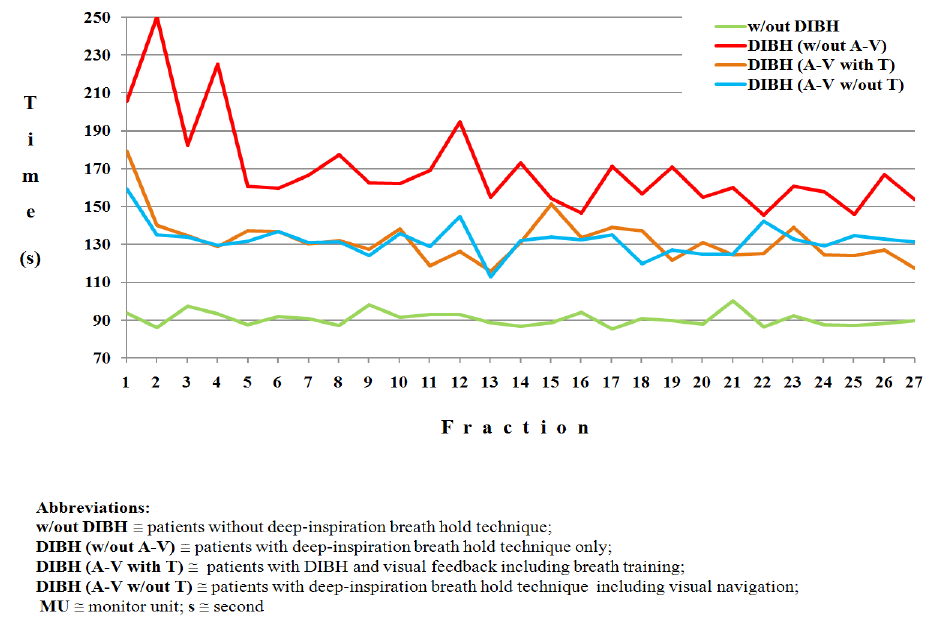
Fig. 2. Treatment times for each fraction converted per 100